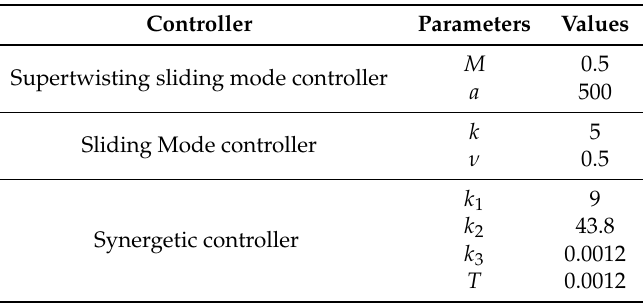
Table 1. Parametric values of the controllers.